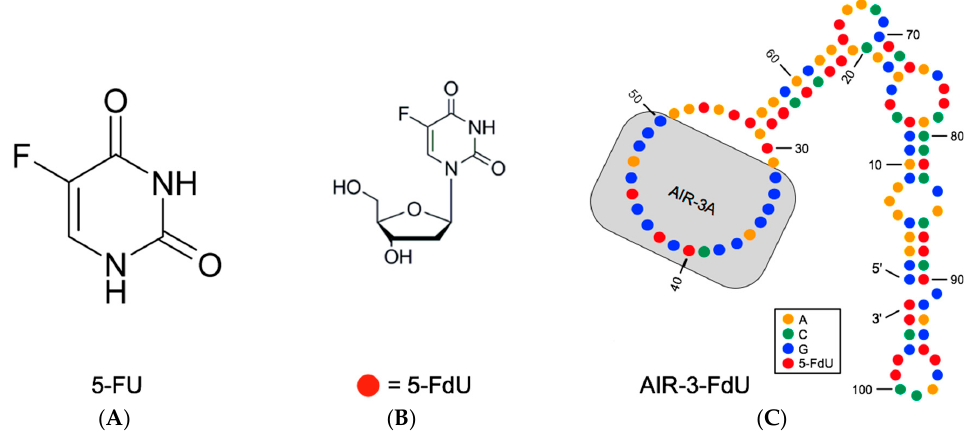
Figure 6. Charomer AIR-3-FdU, a tool for directed cancer drug delivery [27]. Shown are structures of 5-fluorouracil (5-FU; ( A )), 5-fluoro-2 ′ -deoxyuridine (5-FdU; ( B )) and AIR-3-FdU ( C ) a derivative of the IL-6R specific RNA aptamer AIR-3 with each U replaced by 5-FdU (red dots); AIR-3-FdU structure is deduced from a model predicted for the originally selected aptamer AIR-3A with the software Mfold [39]; grey area emphasizes the minimized aptamer version